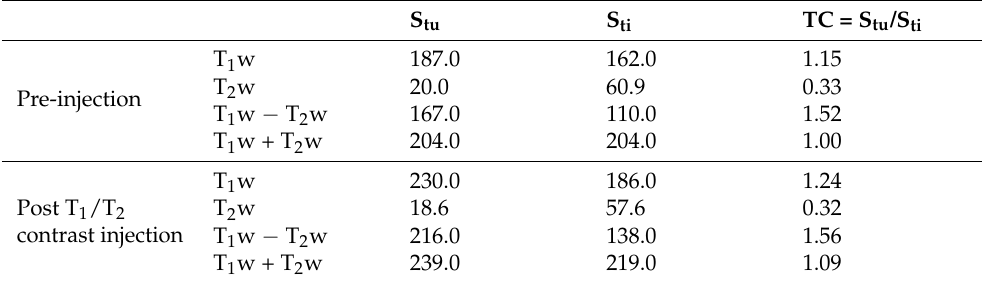
Figure 8. MR images of a mouse bearing TNB tumor 15 min post-injection of non-targeted Na- DyF 4 /NaGdF 4 contrast agent: ( A ) T 1 w. ( B ) T 2 w. ( C ) Image obtained by the subtraction of ( B ) from ( A ). ( D ) image obtained by the addition of ( A , B ). The highest tumor contrast is obtained in image ( C ) and is equal to TC = 1.56.